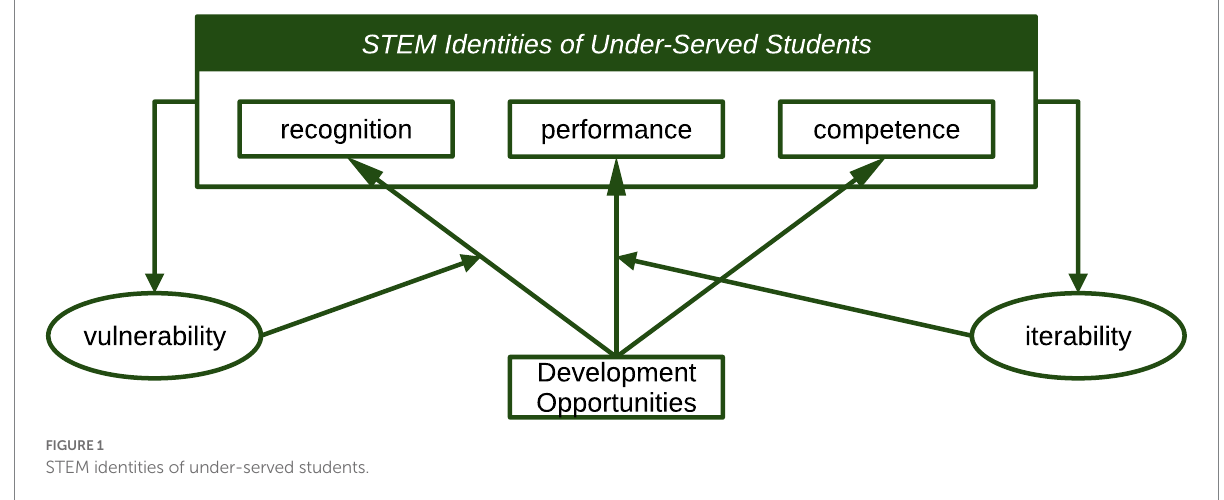
FIGURE 1 STEM identities of under-served